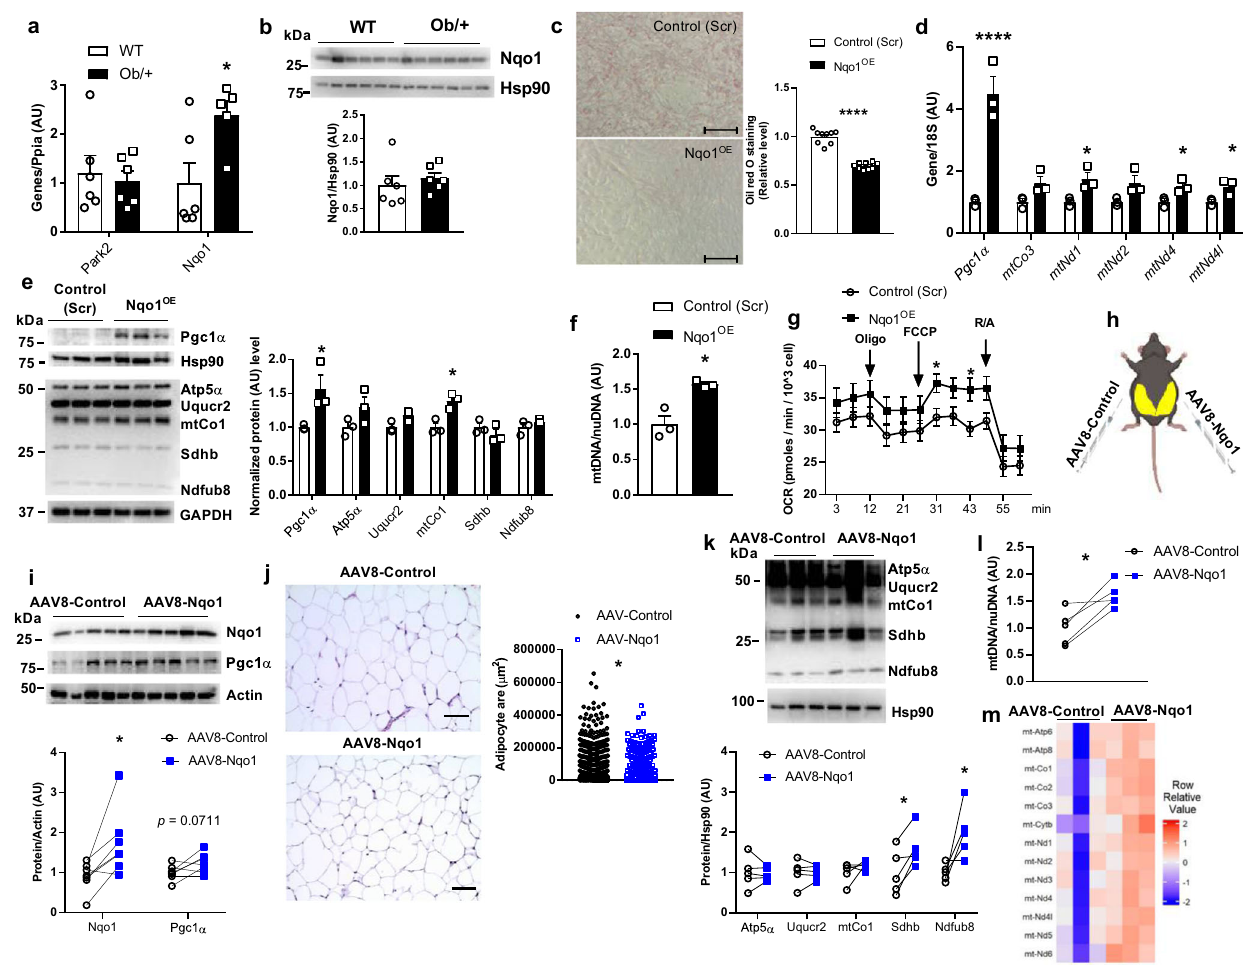
Fig.6|OverexpressionofNqo1enhancesmitochondrialbiogenesisinvitroand in vivo.a mRNA level of Park2 and Nqo1 in eWAT ofWT and Ob/+ mice ( n =6 mice for each group, except one sample in Ob/+ group with undetectable Nqo1 gene expression)[UnpairedStudent ’ s t testtwo-tailed.ForNqo1WTvs.Ob/+, p